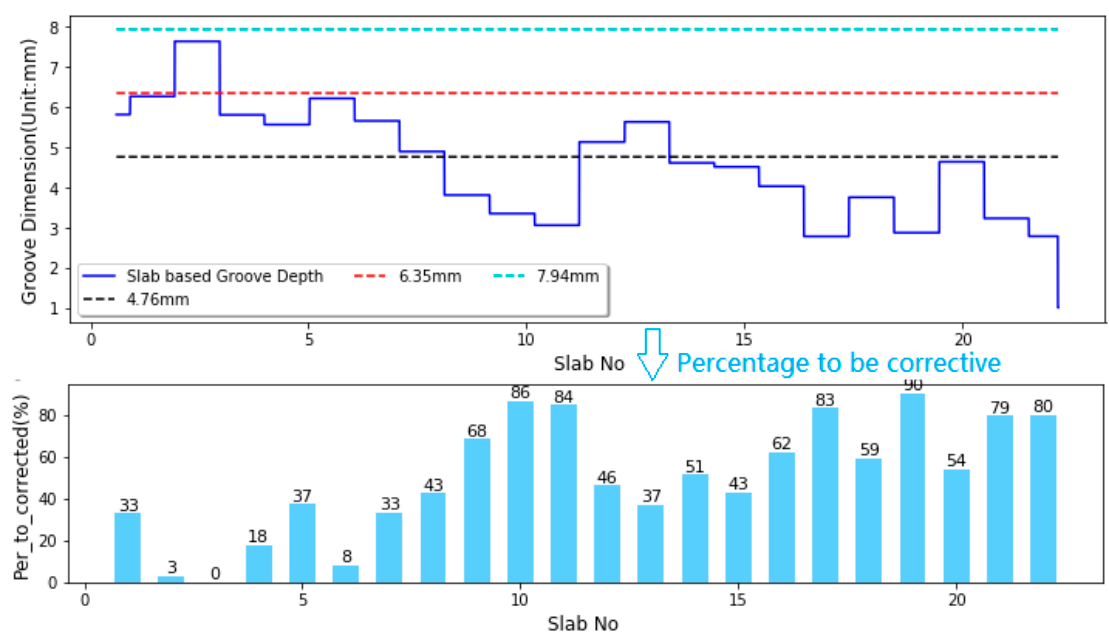
Figure 14. Plots of the groove depths along runway slabs and the corresponding percentage of grooves that need to be maintained.